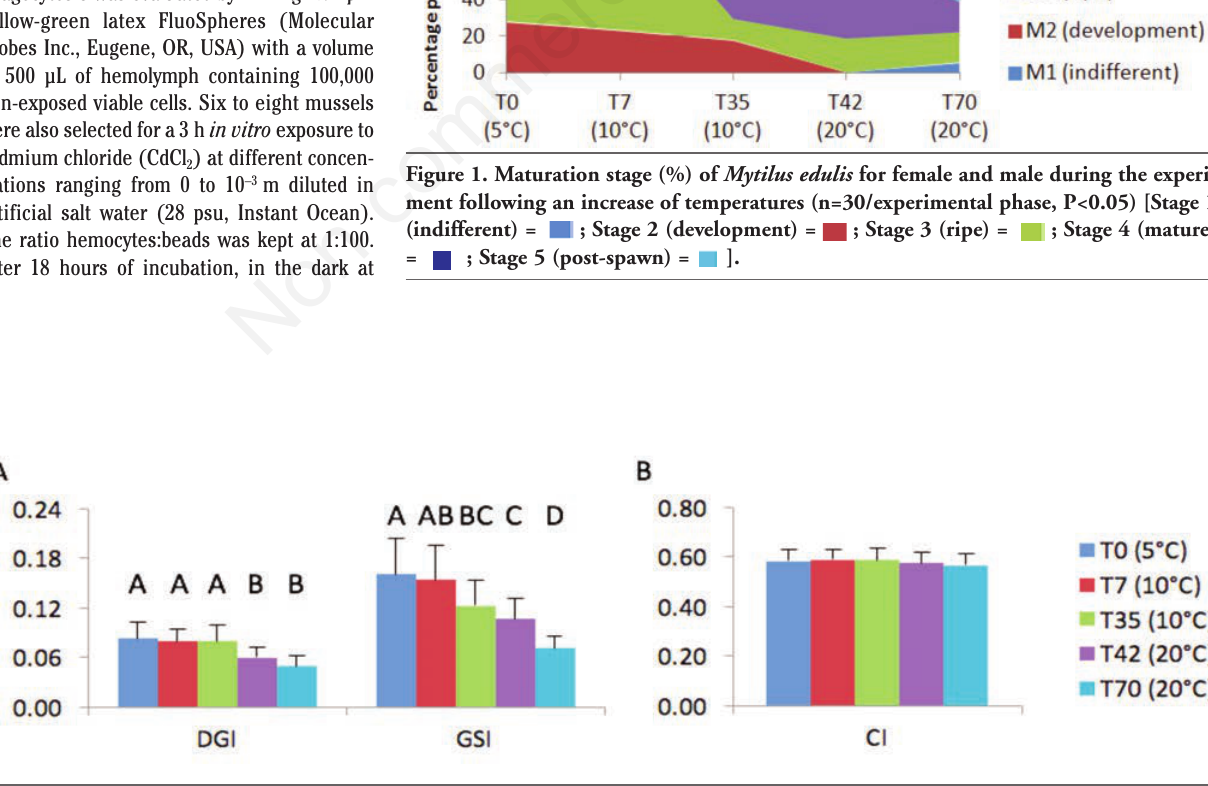
Figure 2. A) Variation of relative weight of digestive gland (DGI) and gonads on total soft tissue (GSI); and B) condition index (CI) during the experiment (n=30/experimental phase,